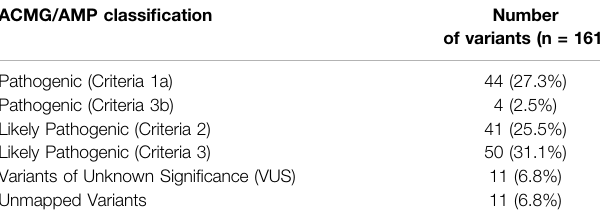
(p.Ser259Leu), GCDH :c.880C > T (p.Arg294Trp), GALT :